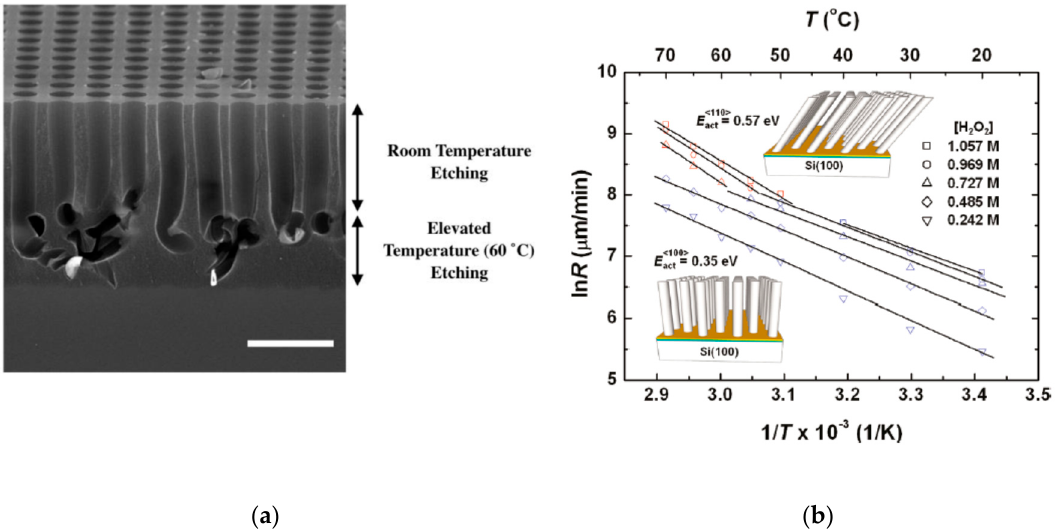
Figure 8. ( a ) Cross-sectional SEM images of the as-etched Si produced with Au catalyst of p -type Si (100) substrate (0.005 Ω cm) in solution of 13.5 M HF and 0.16 M H 2 O 2 at room temperature for 30 min and subsequently etched at the same condition at 60 ˚ C for 1 min. Scale bar is 2 µm. The figure was adapted with permission from L. Kong et al., 2017. [51]. ( b ) Temperature dependence of etching rate for different H 2 O 2 concentration, at high temperature the etching direction changes from (100) to (110). The figure was adapted with permission from J. Kim et al., 2011. [50].